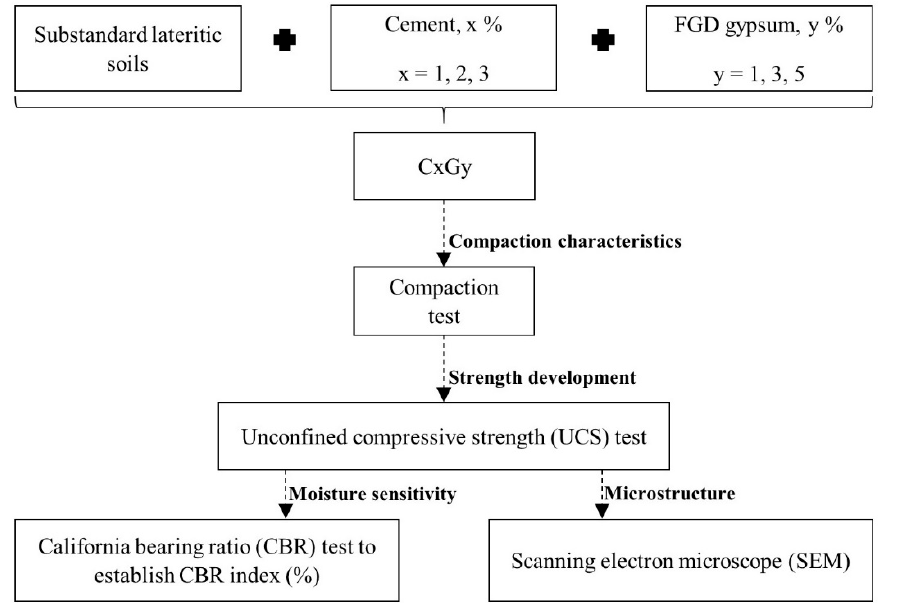
Figure 8. Methodology process of this research. Table 5. Testing